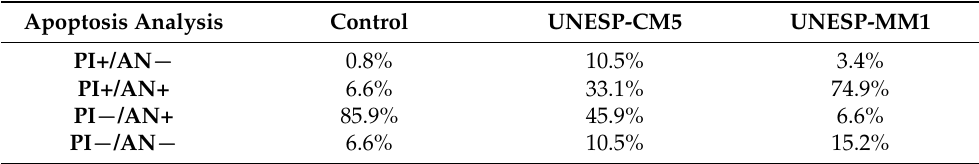
Figure 2. Cell culture experiments of UNESP-CM5 and UNESP-MM1 cancer cell lines. ( A ): cellular viability of canine UNESP-CM5 cell line under different firocoxib concentrations. ( B ): UNESP-MM1 cell line viability after treatment with different firocoxib concentrations. ( C ): Annexin V (AN) and propidium iodide (PI) assay in a pool of both cell lines (UNESP-CM5 and UNESP-MM1) without treatment as a negative control. The control cells presented more than 85% viability (PI − /AN − ). ( D ): UNESP-CM5 cell line presenting 33.1% of the cells with PI+/AN+ and 45.9% of the cells negative for both. ( E ): UNESP-MM1 cell line showing more than 74% of the cells positive for PI and AN (PI+/AN+). The asterisk (*) means statistical difference compared with control group. Table 1. Evaluation of the number of cells positive for annexin V (AN) and propidium iodide (PI) in control, UNESP-CM5, and UNESP-MM1 groups.